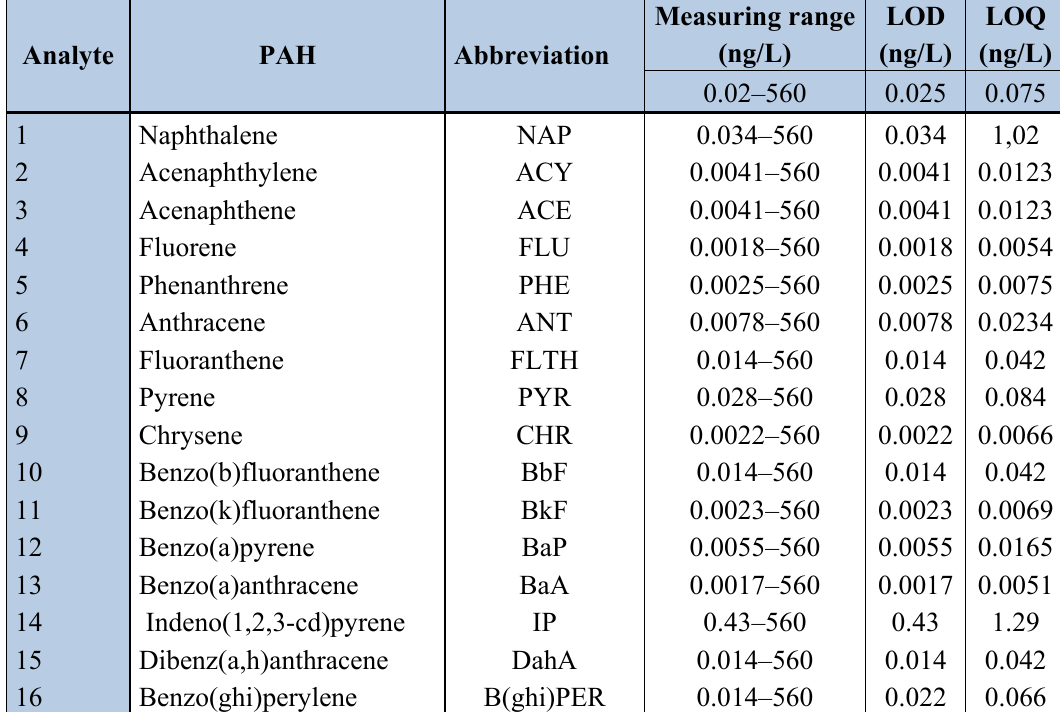
Table 3. Metrological characteristics of the analytical procedure used during this